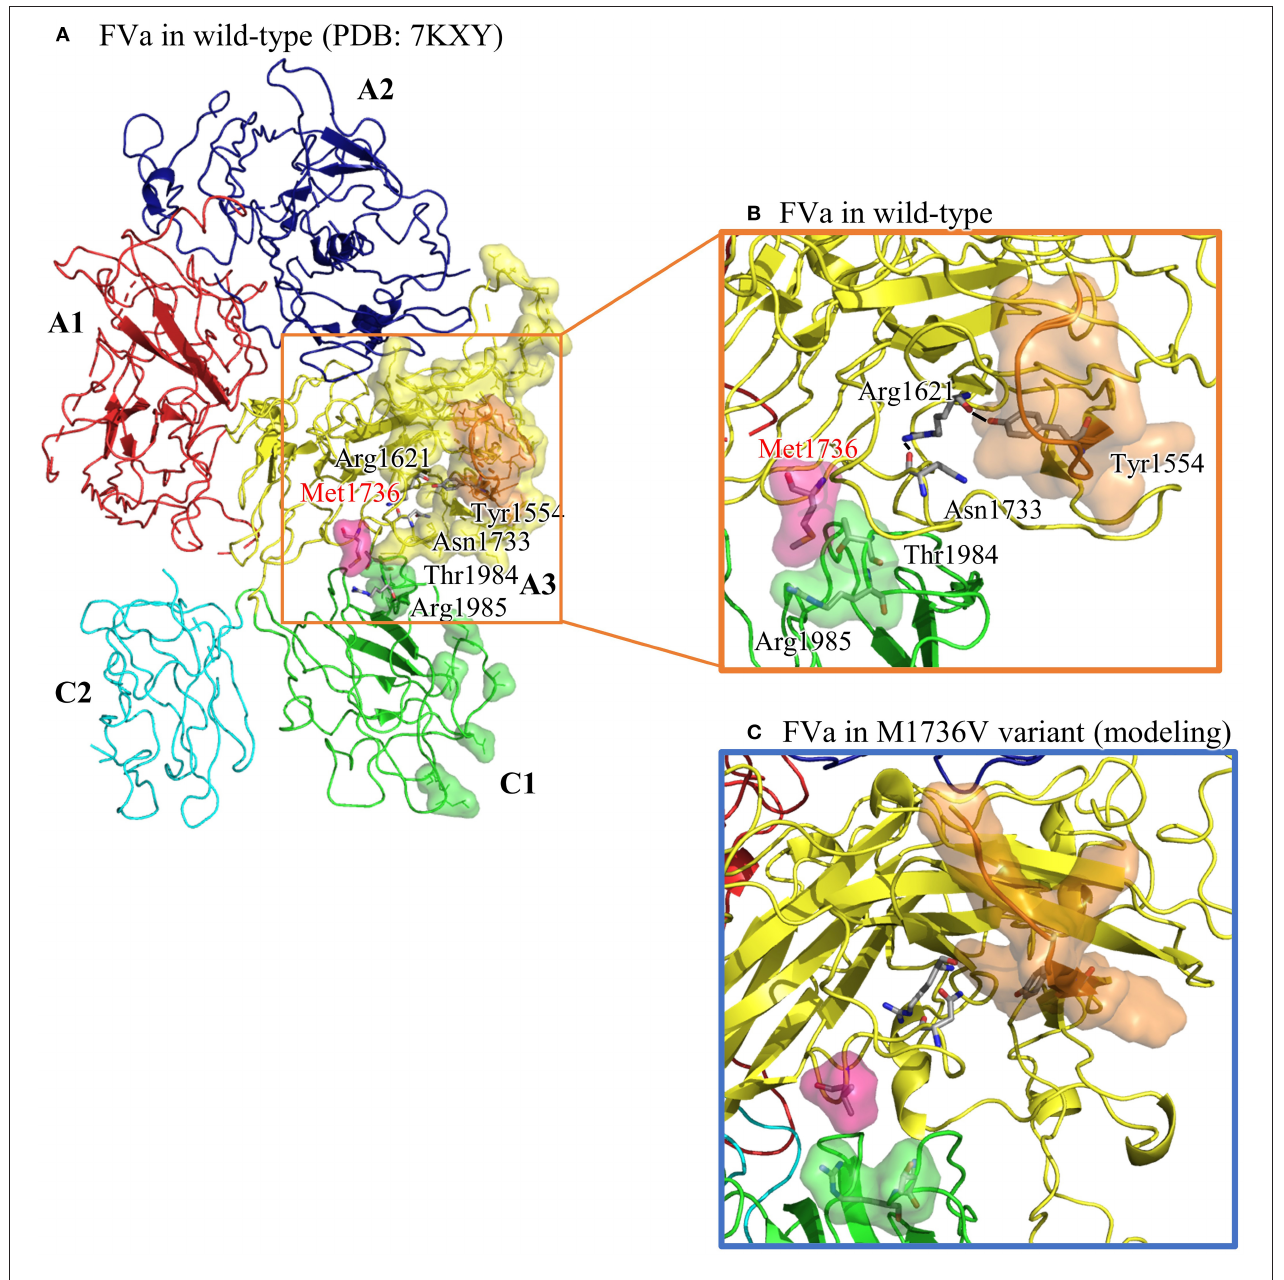
FIGURE 2 | The structural analysis of FVa in wild type (in PDB: 7KXY) and in Met1736Val variant obtained by molecular modeling using GaMD. (A) The overall FVa structure is composed of A1 (in red), A2 (in navy blue), A3 (in yellow), C1 (in green), and C2 (in turquoise) domains. A3 residues interacting with FXa and prothrombin are encompassed by yellow surface, whereas C1 residues interacting with prothrombin are encompassed by green surface. The Asn1547–Asn1555 (N1547–Y1555) segment in A3 domain is highlighted in orange surface. (B) A close-up view of the wild type showing Met136 embedded by Thr1984 and Arg1985, and a well-maintained hydrogen bond network linking Asn1733, Arg1621, and Tyr1554. (C) A close-up view of the Met1736Val variant. Val1736 averts from Thr1984 and Arg1985, and Tyr1554 is no longer restrained by Arg1621, which possibly causes reorientation of the Asn1547– Tyr1555